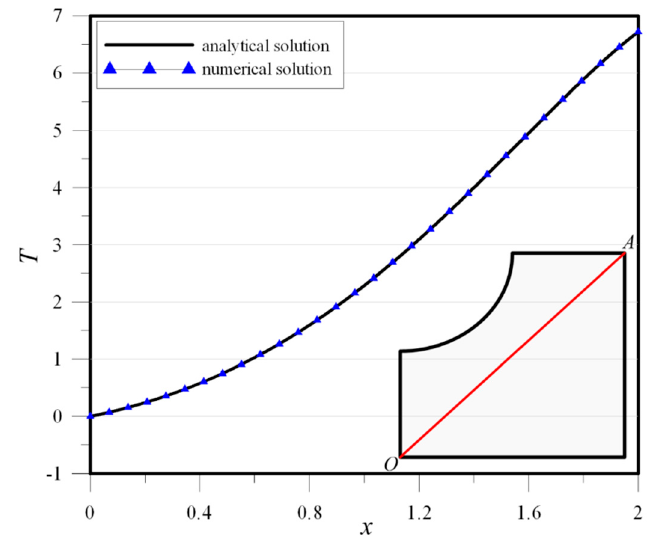
Figure 10. The comparison of the computed results with the analytical solution of temperature along line OA.